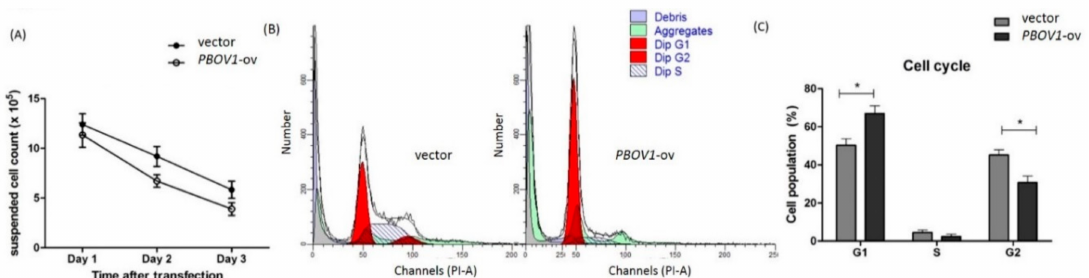
Figure 5. Overexpression of PBOV1 in THP-1 cells results in cell cycle arrest. ( A ) Count of suspended THP-1 cells after transfection of PBOV1 -overexpression vectors; n = 6, bars represent mean ± SEM. ( B ) Cell cycle analysis of THP-1 cells transfected with control vector (left) or with PBOV1 -overexpression vector (right) for 48 hours; here are representative graphs of four independent experiments, showing G1 arrest in PBOV1 -overexpressing THP-1. ( C ) Percentage of THP-1 cells in Gap 0/Gap 1 (G0/G1), Synthesis (S), and Gap 2/Mitosis (G2/M) phase; n = 4, bars represent mean ± SEM. * p < 0.05 by Mann Whitney U